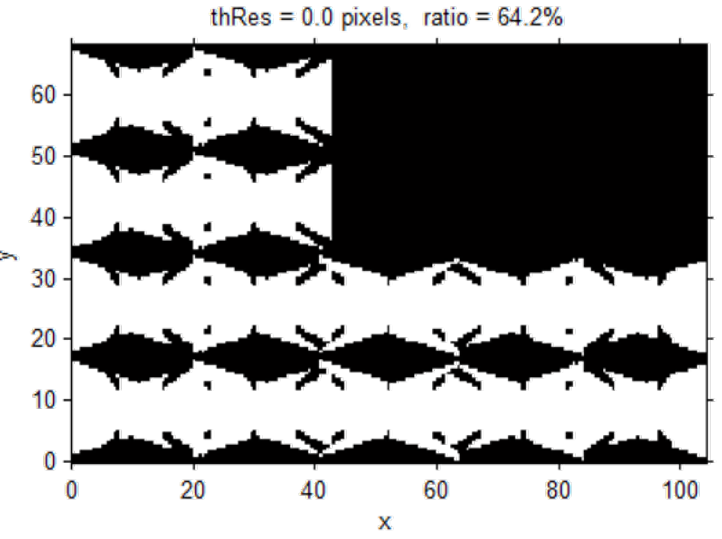
Figure 5. Areas with a surveillance resolution greater than 0 when objects are on the bottom and their orientations are upper vertical (white: resolution > 0 px/cm ; black: resolution = 0 px/cm ).